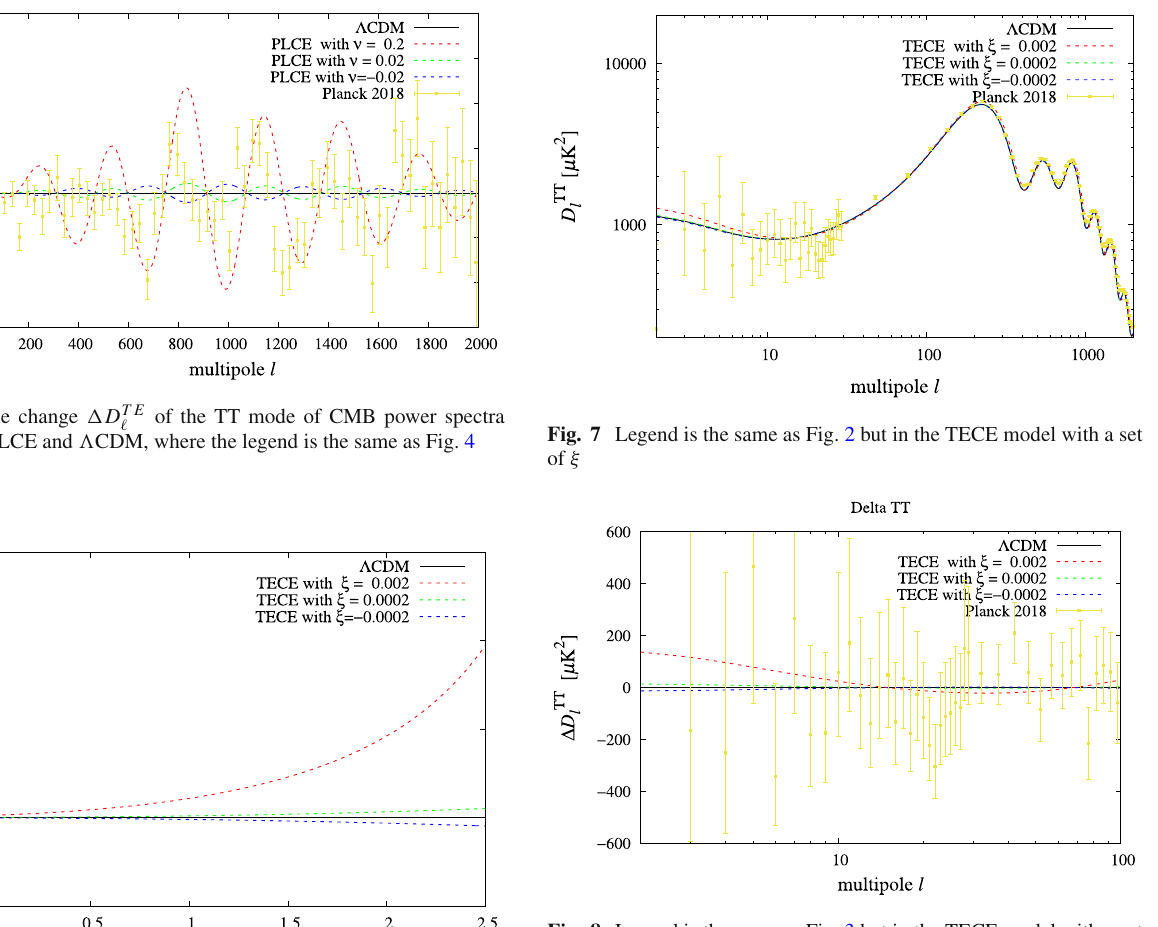
Fig. 8 Legend is the same as Fig. 3 but in the TECE model with a set of ξ